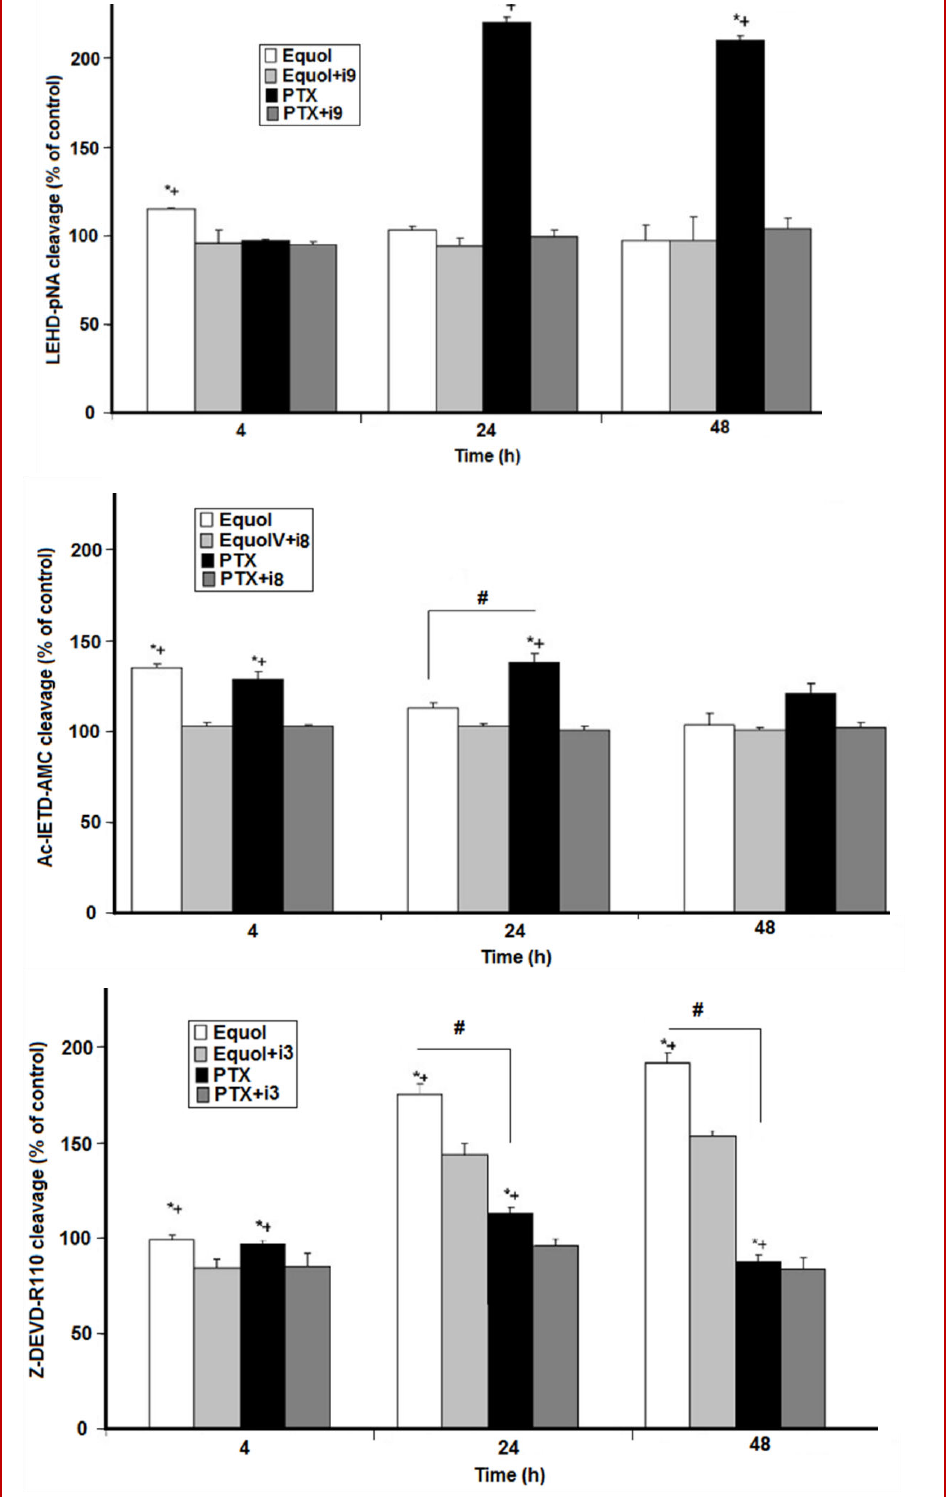
Figure 5: Time-dependent changes in caspase-9, -8 and -3 activity in SKOV-3 cells treated with an IC 50 dose of equol and PTX for